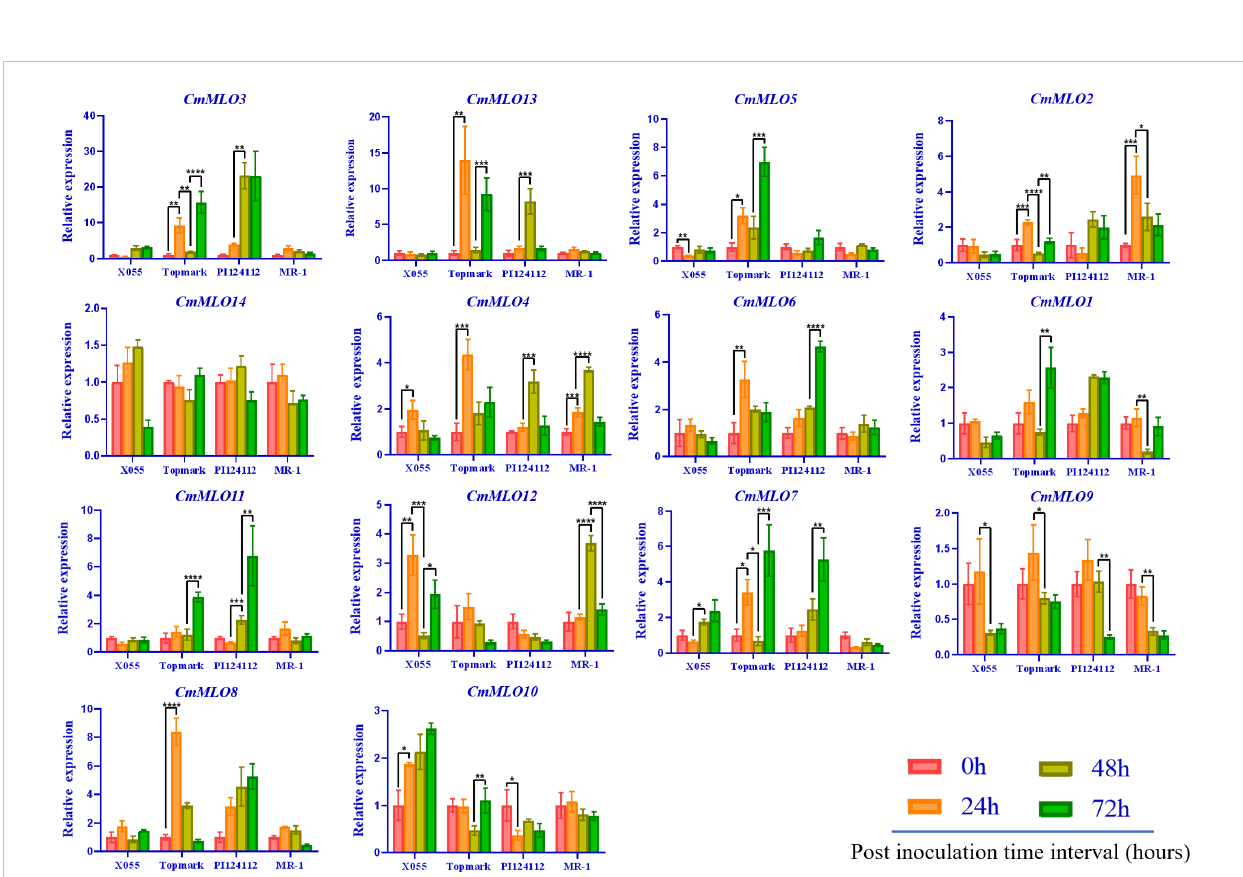
FIGURE 8 The MLO genes expression analysis in different melon materials after infection at different time points. CmActin was used as an internal control, samples at 0 h after inoculation were used as controls, and the error line is the standard deviation of three biological replicates. Asterick symbols (*, **,***,****) are representing the signi fi cant results at **p < 0.01, ***p < 0.001, ****p < 0.001, and *p < 0.05 level,